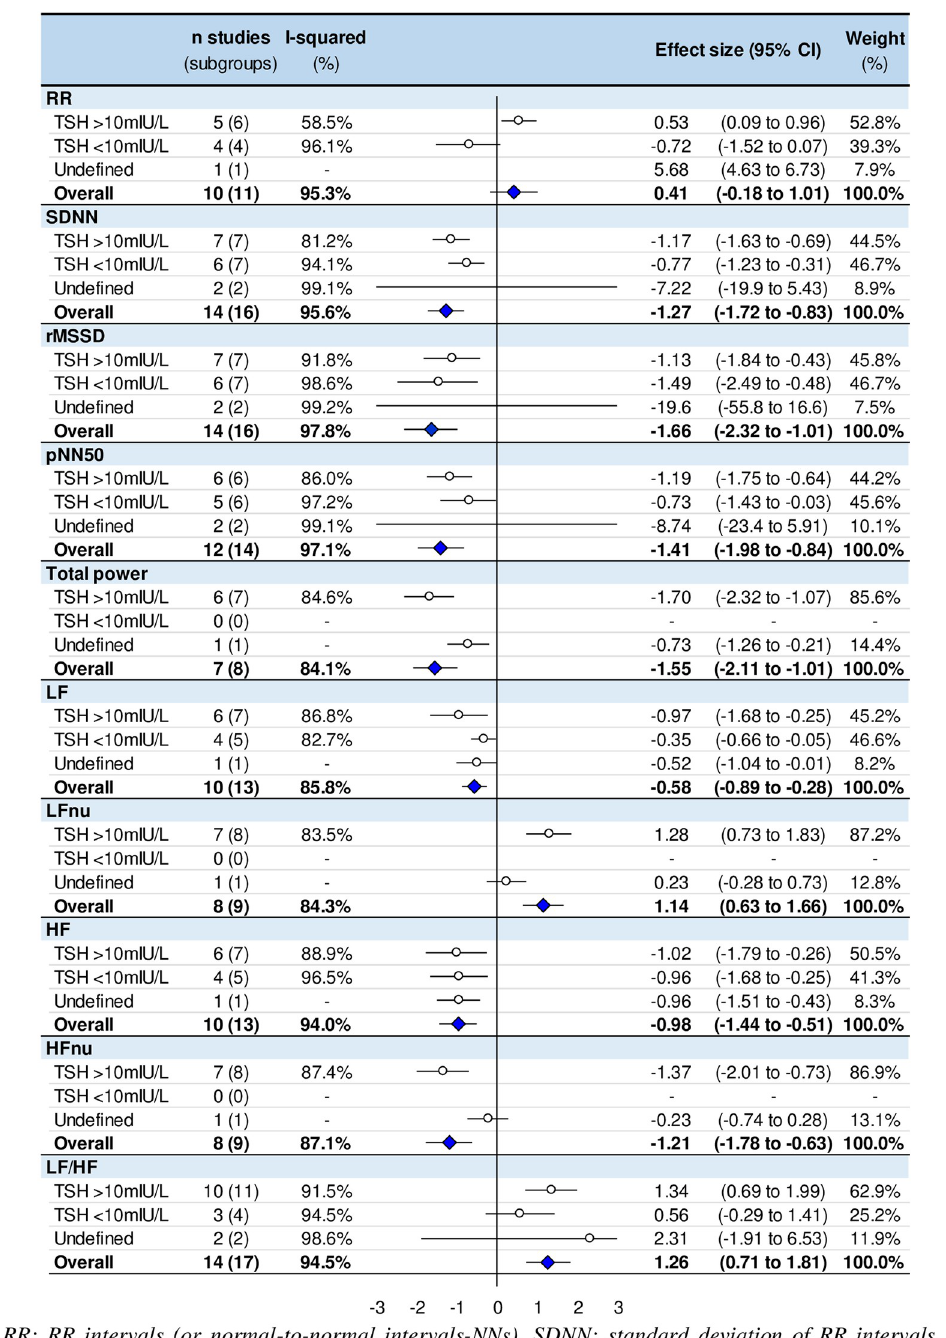
PLOS ONE | https://doi.org/10.1371/journal.pone.0269277 June 3,